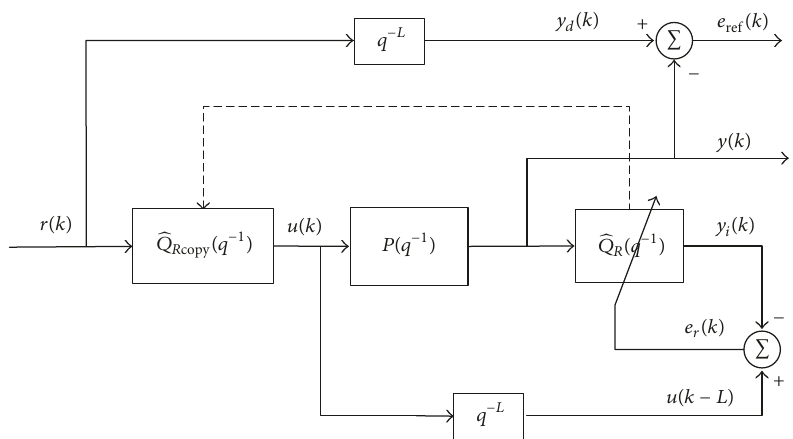
Figure 2: Indirect control scheme for non-minimum phase plants [4].